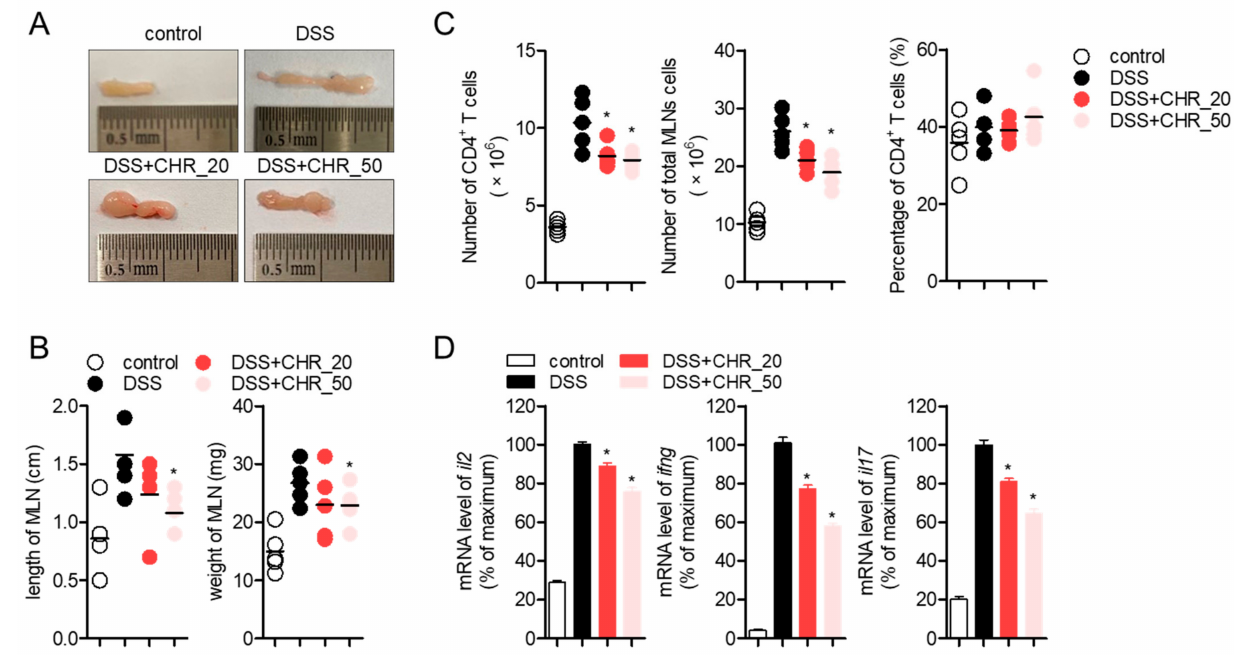
Figure 6. Oral administration of chrysophanol decreases the expression of effector cytokines from mesenteric lymph nodes. ( A ) The representative images of mesenteric lymph nodes from each mice group. ( B ) The length and weight of mesenteric lymph nodes from each mice group. ( C ) The number of CD4 + T cells, total mesenteric lymph nodes (MLNs) cells and percentage of CD4 + T cells in total MLNs cells. ( D ) The mRNA levels of the indicated genes on CD4 + T cells isolated from mesenteric lymph nodes were normalized with the levels of GAPDH and presented in percentage of maximum. The mean value of five mice ± SEM is presented. * p < 0.05 compared with DSS-treated